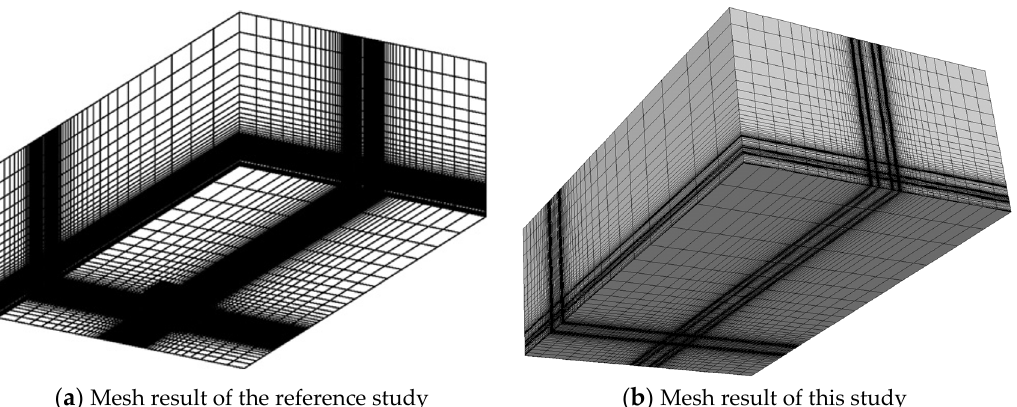
Figure 7. Perspective view of the grid at the bottom, side, and back face of the computational domain: ( a ) mesh result of the reference study; and ( b ) mesh result of this study.